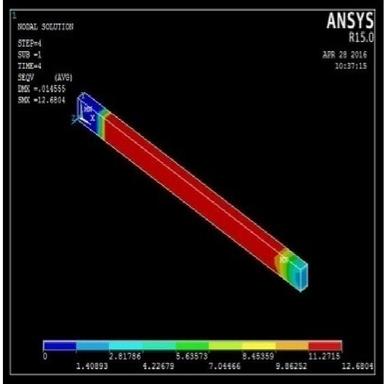
Simulation Results of Compressive Test Specimen at load 235.44 N.